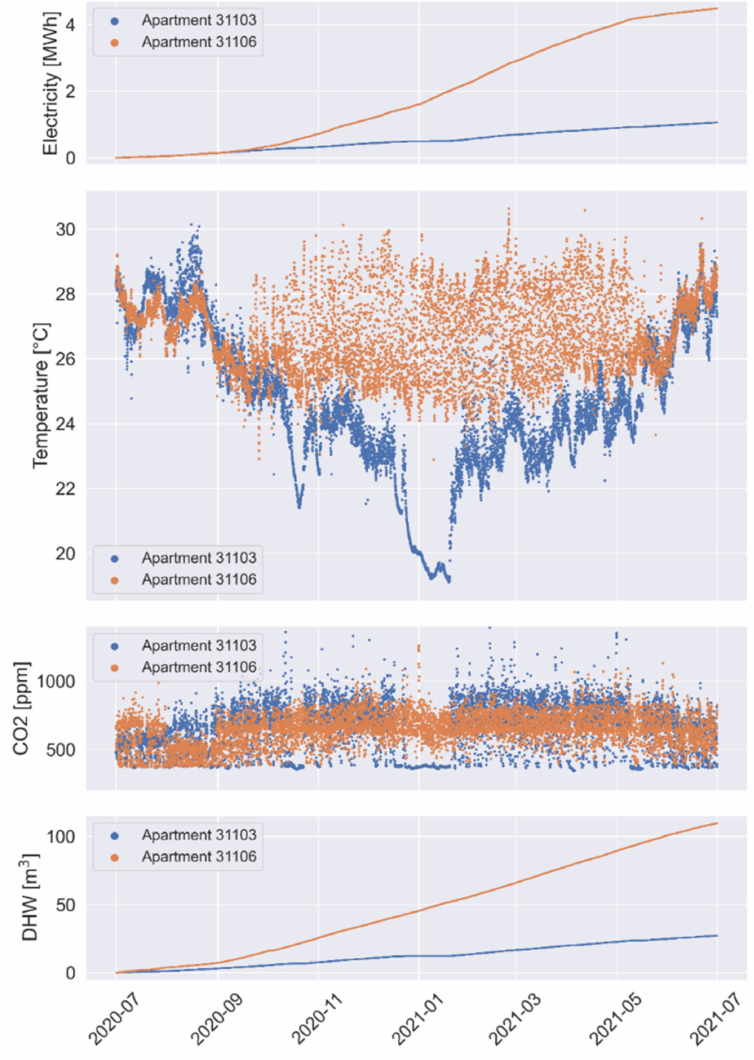
Figure 39. Indoor temperature, CO 2 concentration, cumulative electricity use and cumulative DHW use of apartments 31103 and